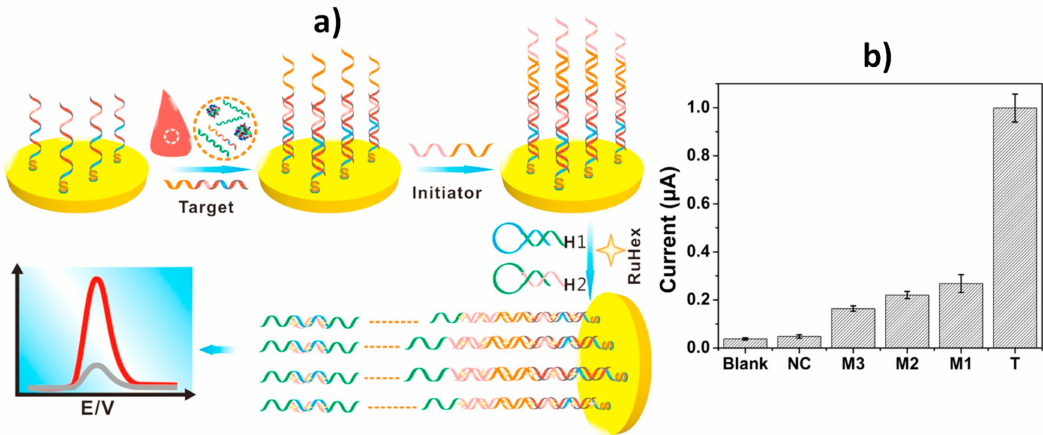
Figure 3. ( a ) Schematic illustration of the HCR-based DNA sensor for BRCA1 determination. ( b ) DPV responses provided by the DNA sensors towards 20 pM of synthetic sequences of the target DNA (T), single-base (M1), two-base (M2), three-base (M3) mismatched and non-complementary (NC) sequences. Reprinted and adapted from [24] with